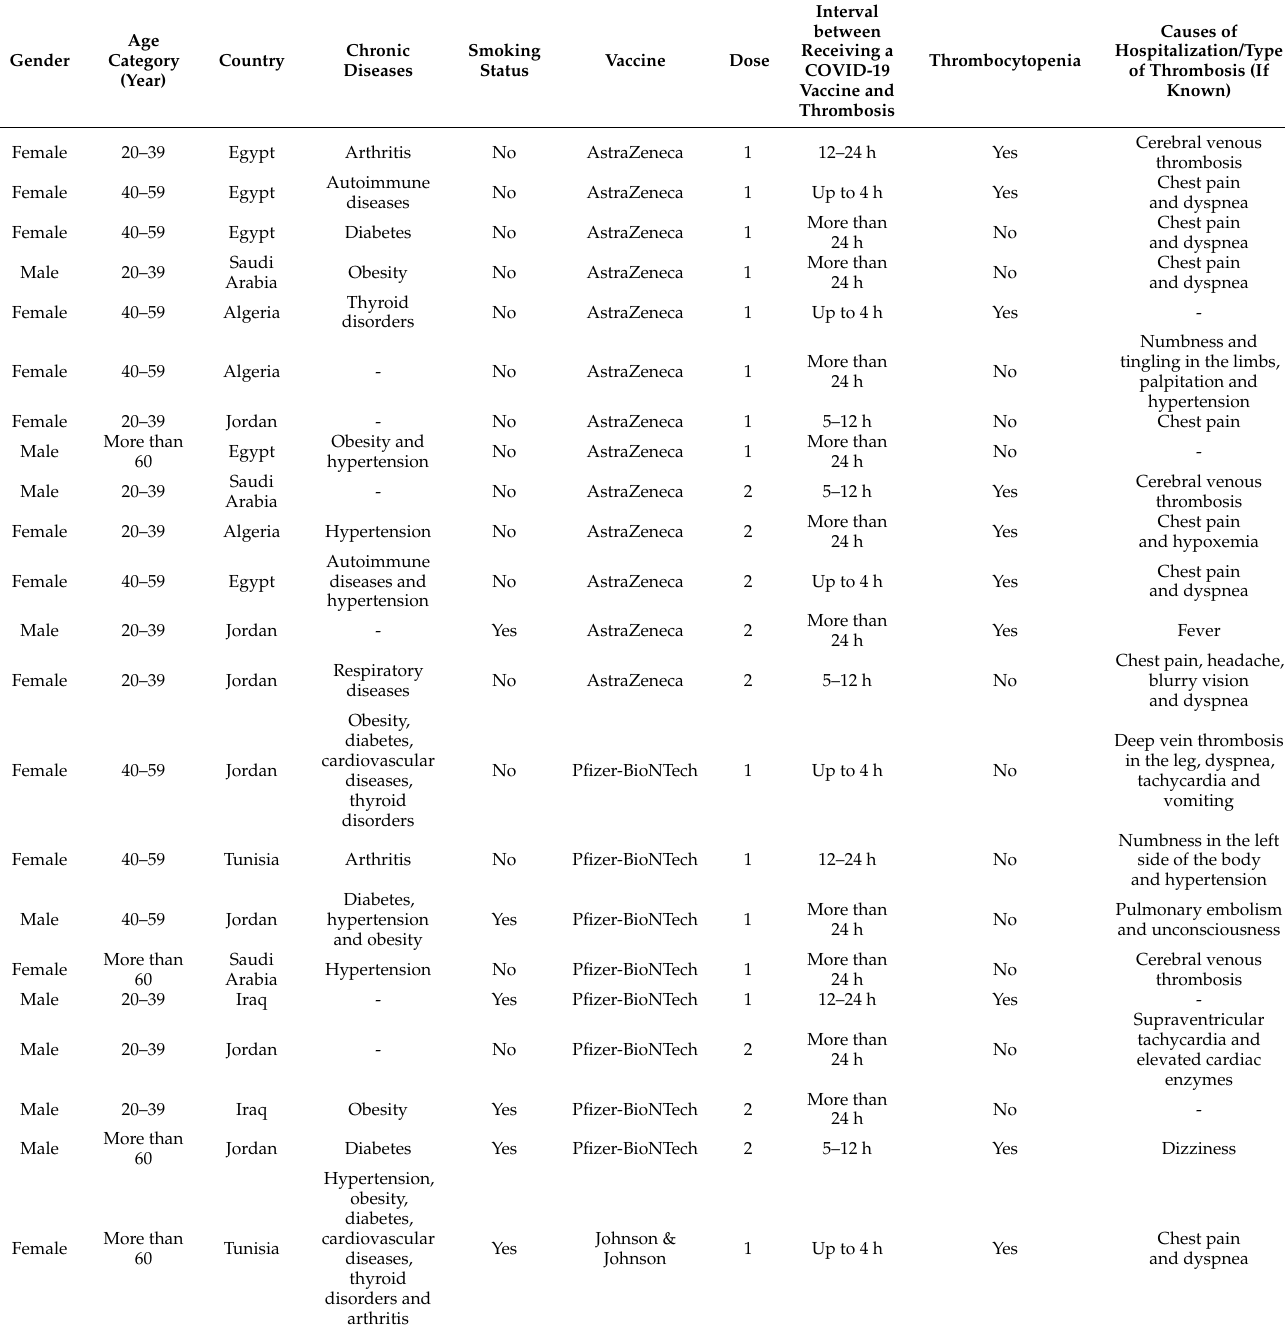
Table 10. Characterization of participants who experienced thrombosis following COVID-19 vaccina- tion ( n = 22). All of them were admitted to hospitals and needed more than one week to